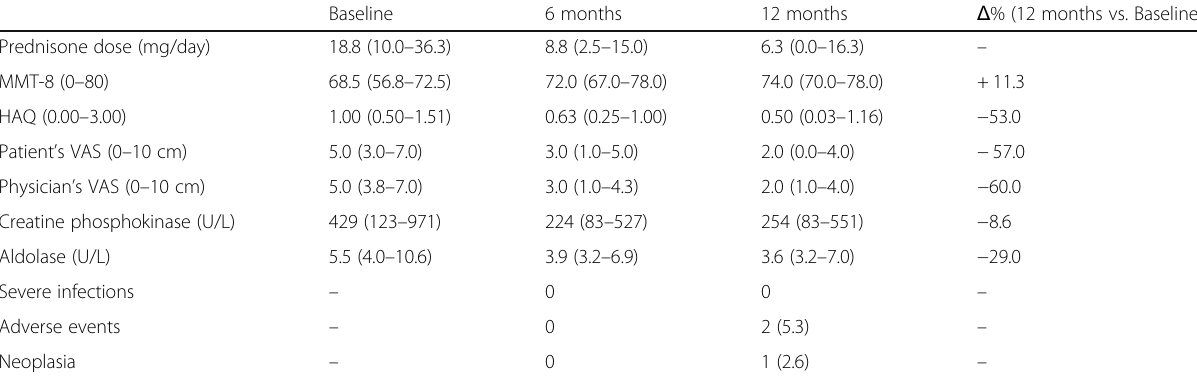
Table 2 Evaluation at baseline, 6 and 12 months of 38 patients with idiopathic inflammatory myopathies after rituximab therapy